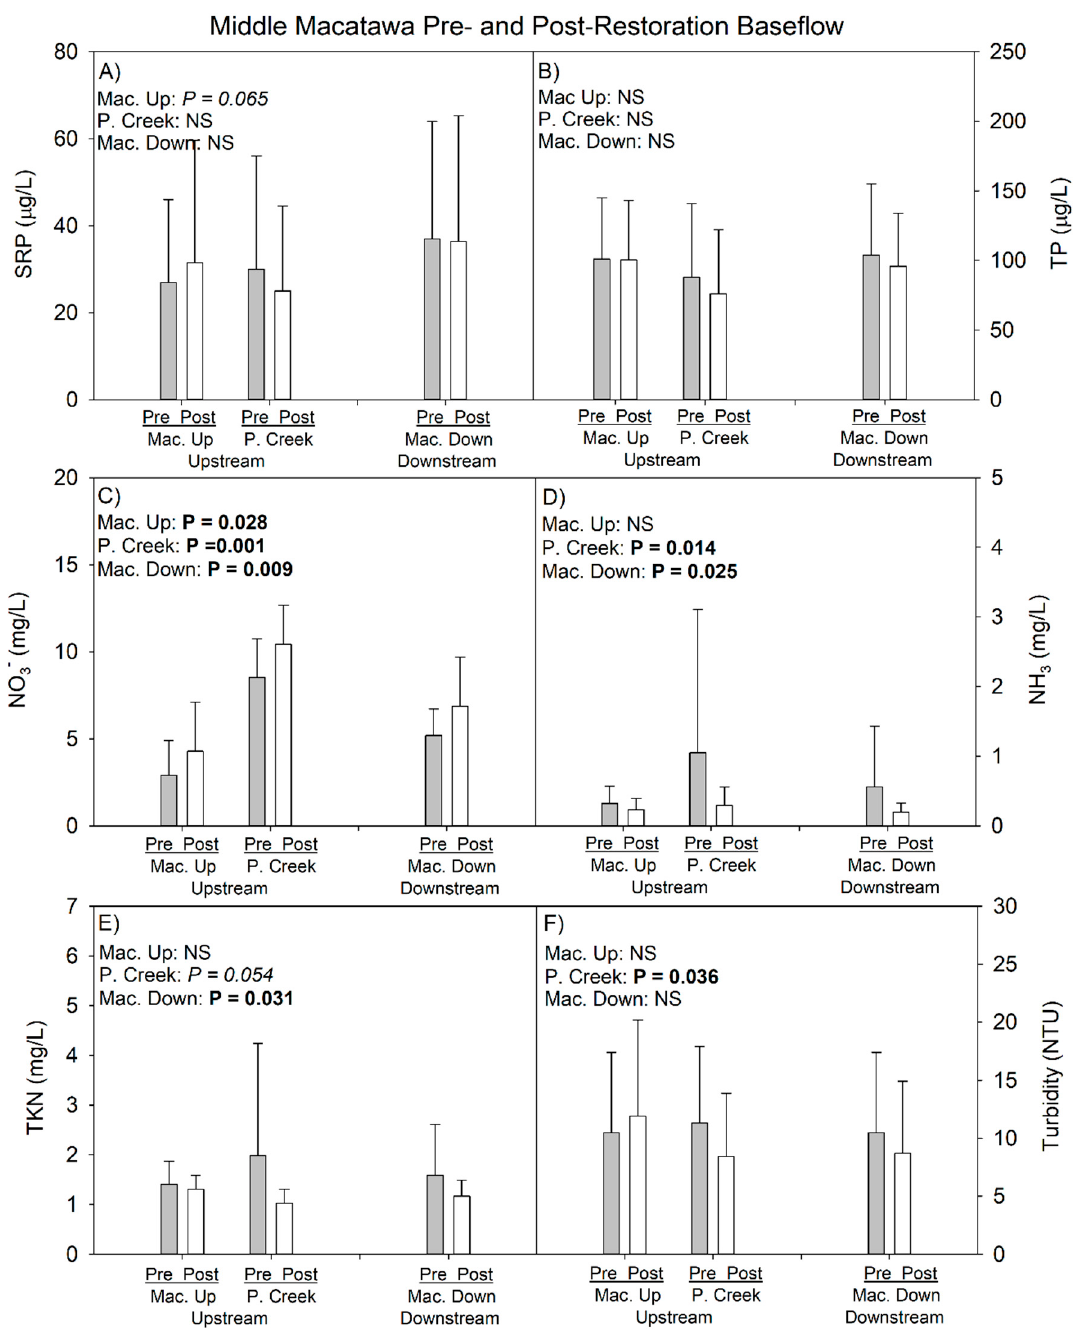
Figure 5. Mean (1 SD) Middle Macatawa pre- and postrestoration nutrient value comparison at baseflow in 2017 sampling year. p -values in top left corner of each panel represent pre- vs. postrestoration statistical analysis within each site. Mac. Up = Macatawa Upstream site; P. Creek = Peters Creek; Mac. Down = Macatawa Downstream site. See Figure 1B for site locations.